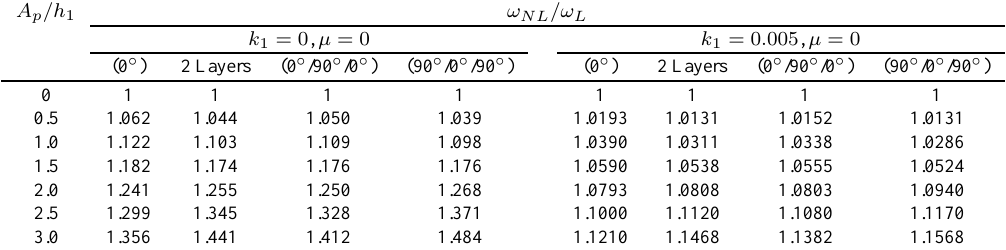
Table 6 Variationoftherelativefrequencywithrespecttoamplitudeofthefrequency, numberandorderingoflayersfor k 1 = 0 . 005